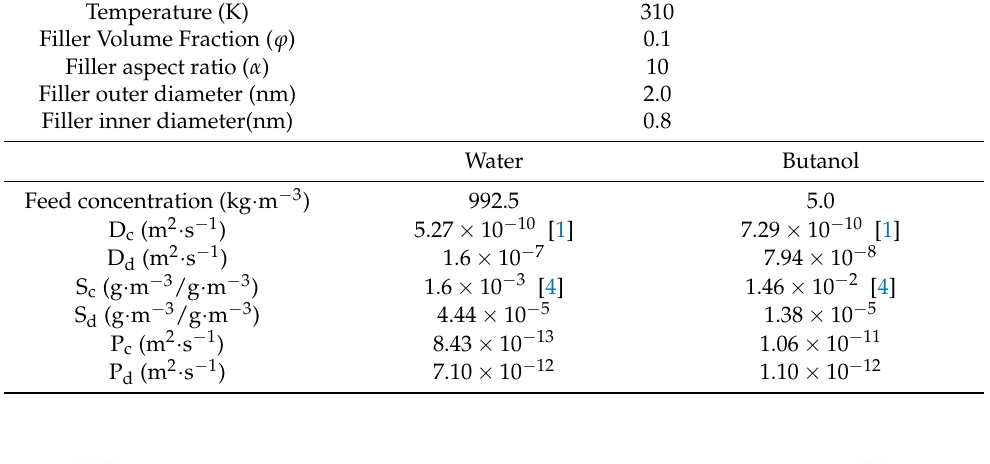
Table 3. Summary of simulation details for the continuous and dispersed phases.